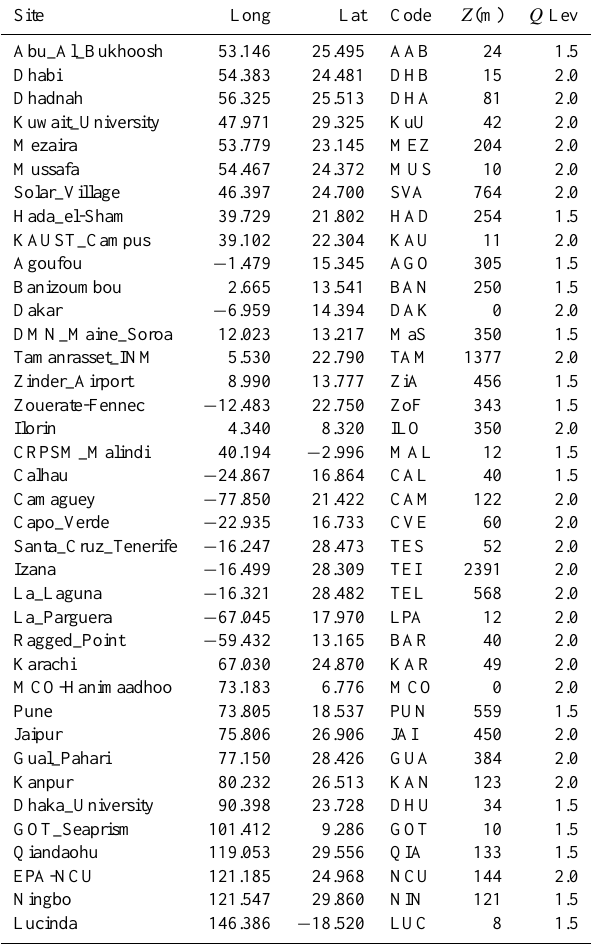
Table 1. List of the 38 AERONET sites selected for this study: name, longitude (degree), latitude (degree), three-letter code, ele- vation (in m), 500nm coarse-mode AOD data quality